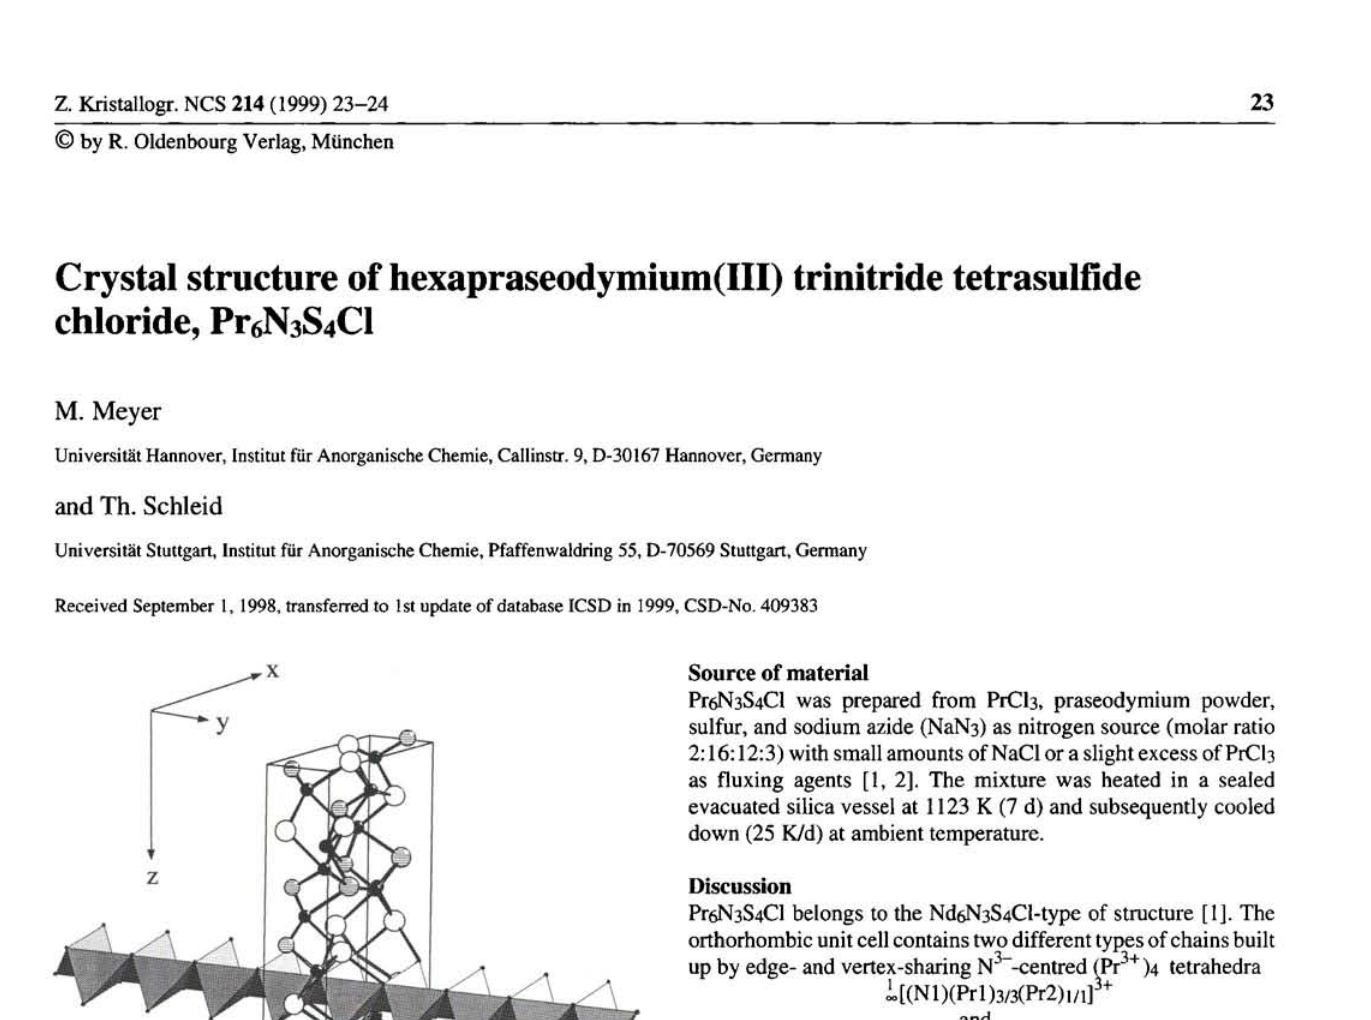
Table 1. Data collection and handling. Crystal: